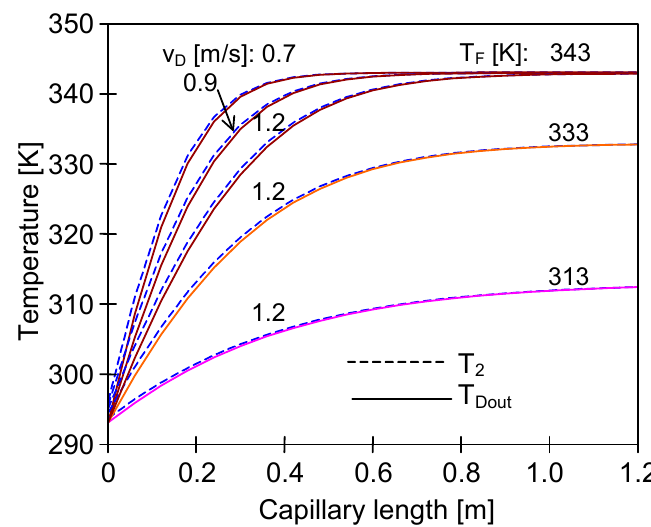
Figure 12. The influence of distillate flow rate and T F on the distribution of the T 2 and distillate outlet temperature along the membrane length. Mode 1. Membranes PV370, L = 120 cm.